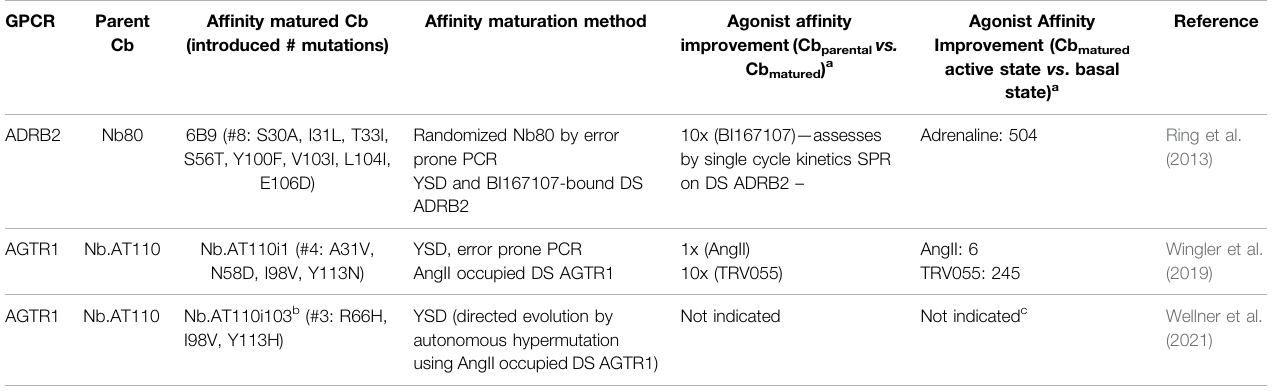
TABLE 2 | Examples and characteristics of af fi nity matured Type I ConfoBodies. For uniformity in GPCR nomenclature in this review, the GPCR synonym of the UniProt database is the one indicated in Figure 4 . Abbreviations: yeast surface display (YSD), detergent soluble (DS). GPCR Parent Af fi nity matured Cb Af fi nity maturation method Agonist af fi nity Cb (introduced # mutations) improvement(Cb parental